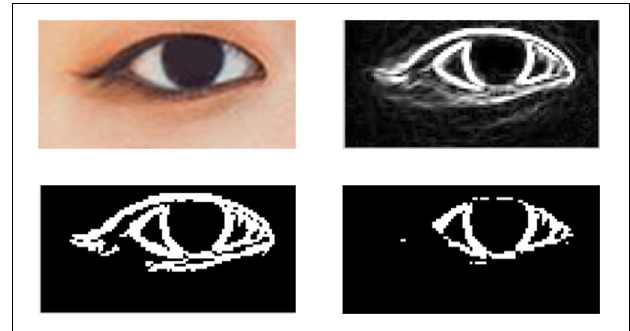
FIGURE 6 | These four are images of eye after normalized, processed by edge detection with sobel operator, searched for the connected area with the largest edge pixel and made interference correction.